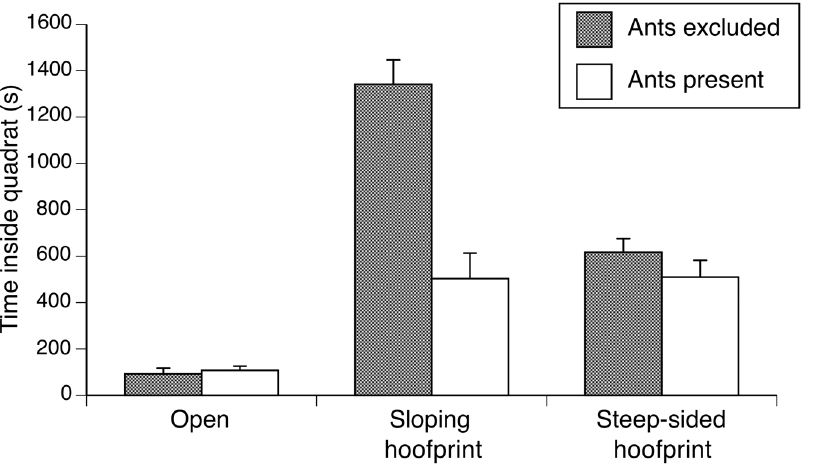
Figure 4. Mean time ( + 1 SE) spent by metamorph cane toads in quadrats with open substrate, a gently-sloping hoofprint or a steep- sided hoofprint in the presence vs absence of foraging meat